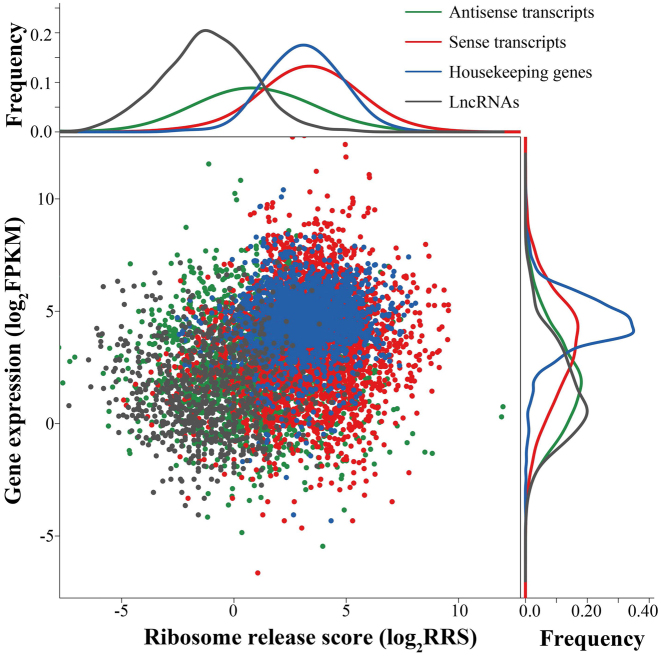
Correlation of gene expression and translational efficiency. A scatterplot of gene translational efficiency (log scale, y-axis) and expression level (log scale, x-axis) for sense and antisense transcripts, housekeeping genes and lncRNAs. Along each axis, all points are summarized using an overlaid density plot. The color code is displayed in top right corner.